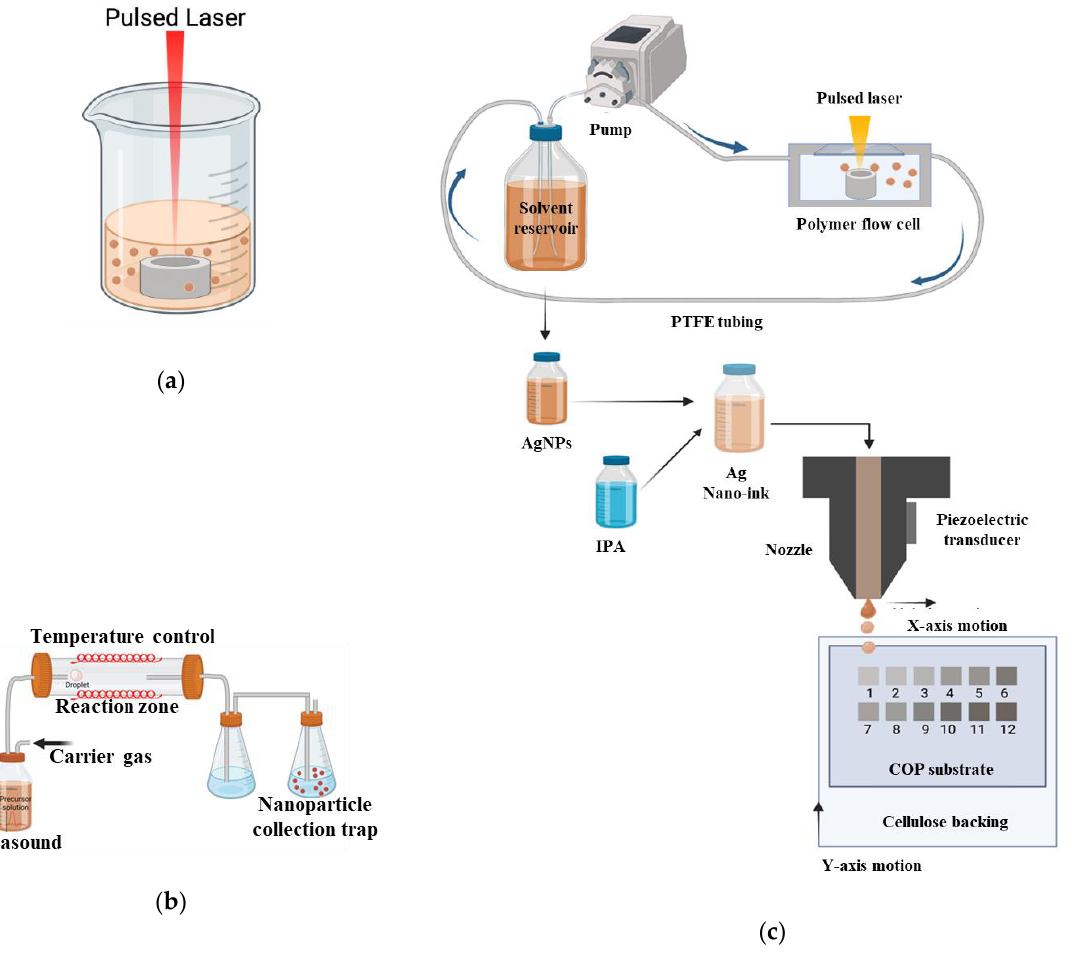
Figure 10. Schematic design of the ( a ) batch LASiS setup including beaker, solvent and target material, ( b ) ultrasonic spray pyrolysis technique and ( c ) recirculatory flow-based LASiS production setup including flow-cell, target, peristaltic pump, solvent reservoir, laser beam, resulting in Ag nano-ink and the inkjet printing process on COP with the numeric digits indicating the quantity of overprints (1 – 12).